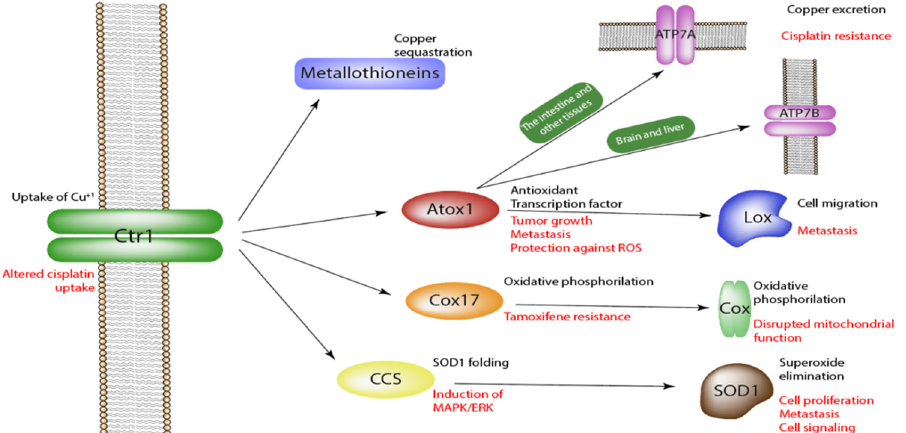
Figure 1. Proteins of copper metabolism. The arrows show how copper is metabolized. In general, CTR1 is responsible for copper intake; numerous metallothioneins and chaperones store the metal and deliver it to the active sites of functional proteins. The black font indicates the role of a protein in normal cells, and the red font indicates the protein function in cancer.